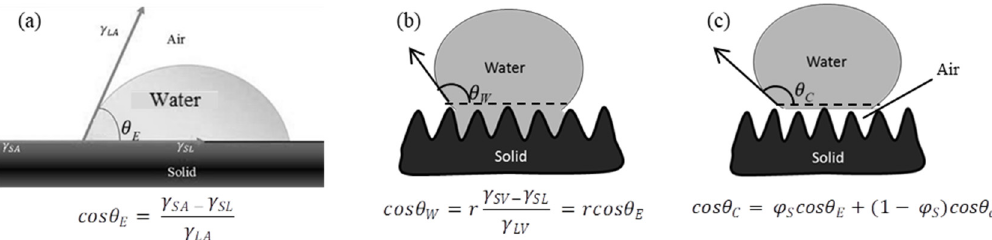
Figure 1. Illustration of the Young ( a ) Wenzel ( b ) Cassie-Baxter ( c ) wetting models. The arrows represent forces, solid-air interfacial tension ( γ SA ), solid-liquid interfacial tension ( γ SL ) and surface tension of liquid ( γ LA ) acting on the three-phase contact line of a liquid drop on a smooth solid surface in air. θ E is the Young equilibrium contact angle, ϕ S and ( 1 − ϕ S ) are the fractions of the solid surface in contact with the liquid and the fraction of air in contact with the liquid on Cassie-Baxter surface, respectively. θ a is the contact angle of the air portion and θ W represents the Wenzel apparent contact angle and r is the roughness factor (the ratio of the true surface area of the solid to its horizontal projection).